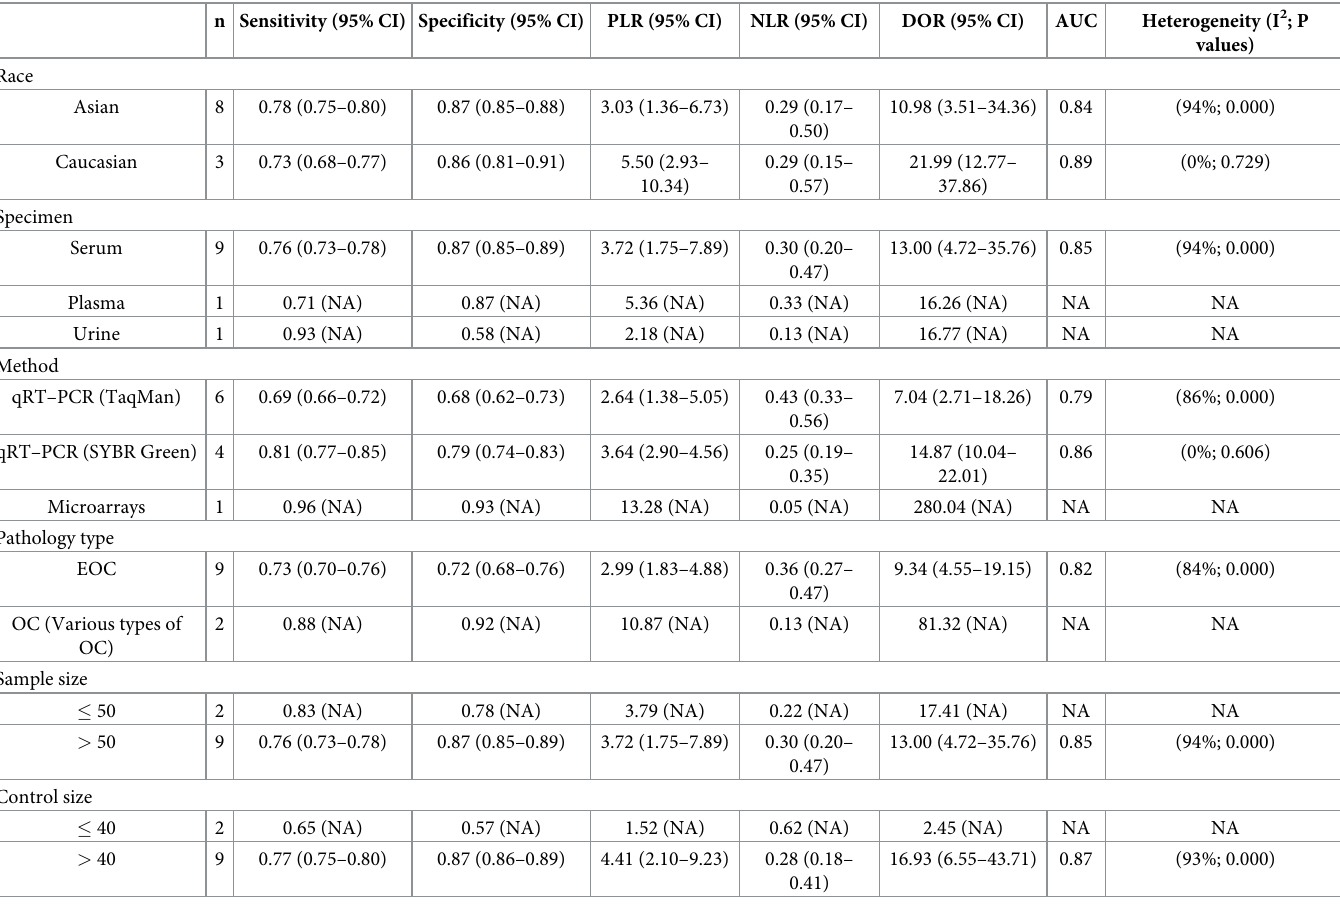
Table 4. Subgroup analysis of the diagnostic efficacy of miRNAs in